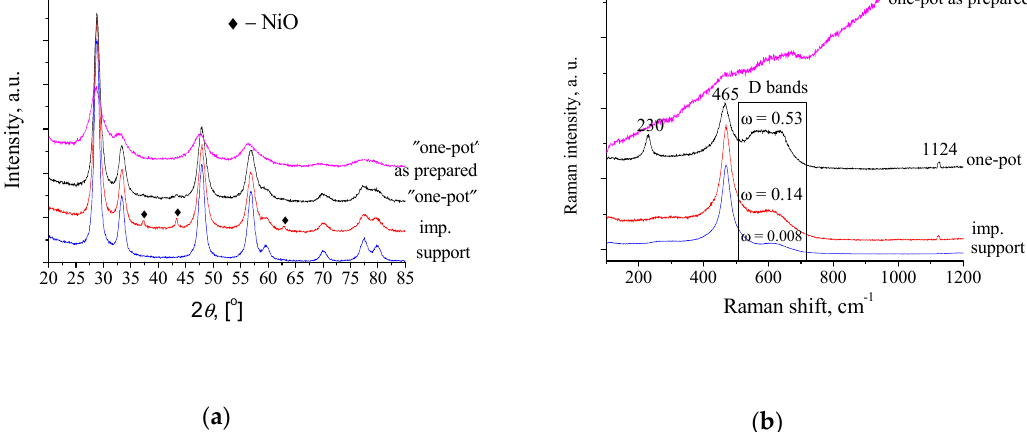
Figure 3. XRD patterns ( a ) and Raman spectra ( b ) of Ni/Ce 0.75 Zr 0.25 O 2 −δ catalysts prepared in supercritical conditions and calcined at 700 °C.